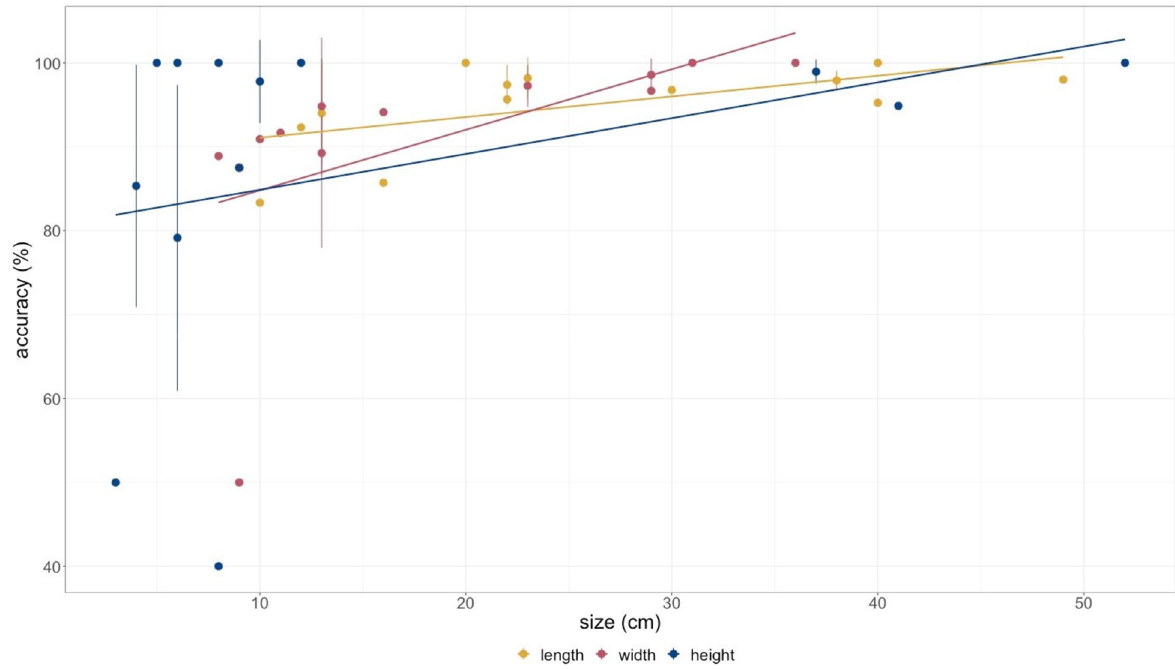
Figure 3. Percentage of accuracy between measured and real values of small objects for length, width and height. Lines show precision of measured values for repeated scans (n = 5) of the same object. Accuracy and precision are increasing with object size in all directions. Lines indicate linear trend lines.